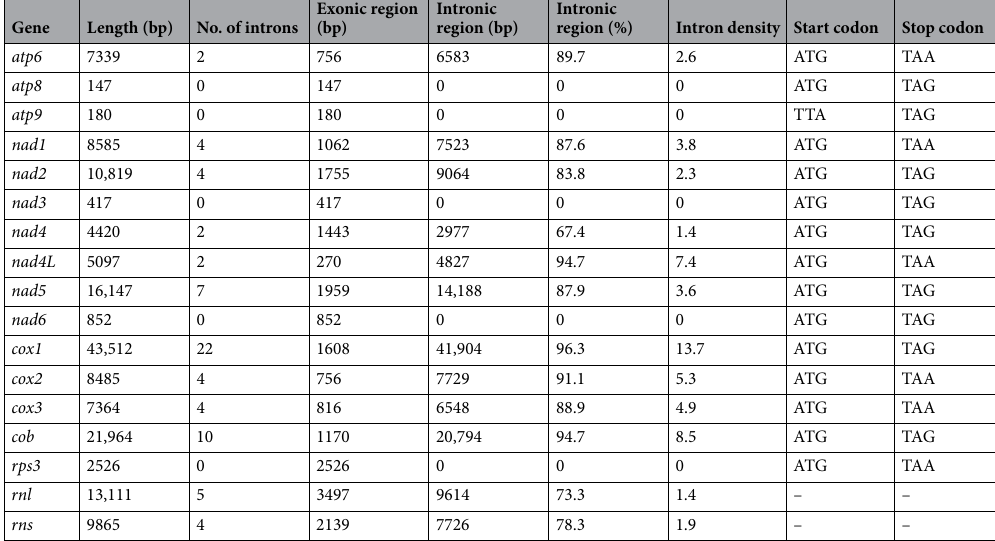
Table 2. Overall statistics of the core mitochondrial genes of Erysiphe necator . Intron density represents the number of introns per kb of exonic sequence.